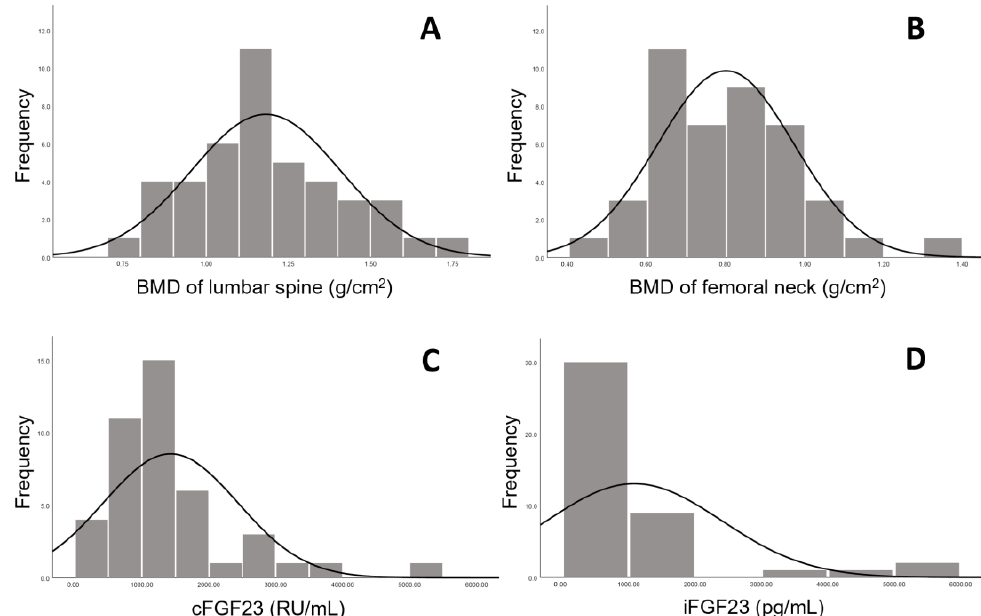
Figure 3. Bone mineral density distributions of ( A ) lumbar spine (L1–L4) and ( B ) femoral neck (bilateral). Distributions of ( C ) c-terminal FGF23 (cFGF23) and ( D ) intact FGF23 (iFGF23).